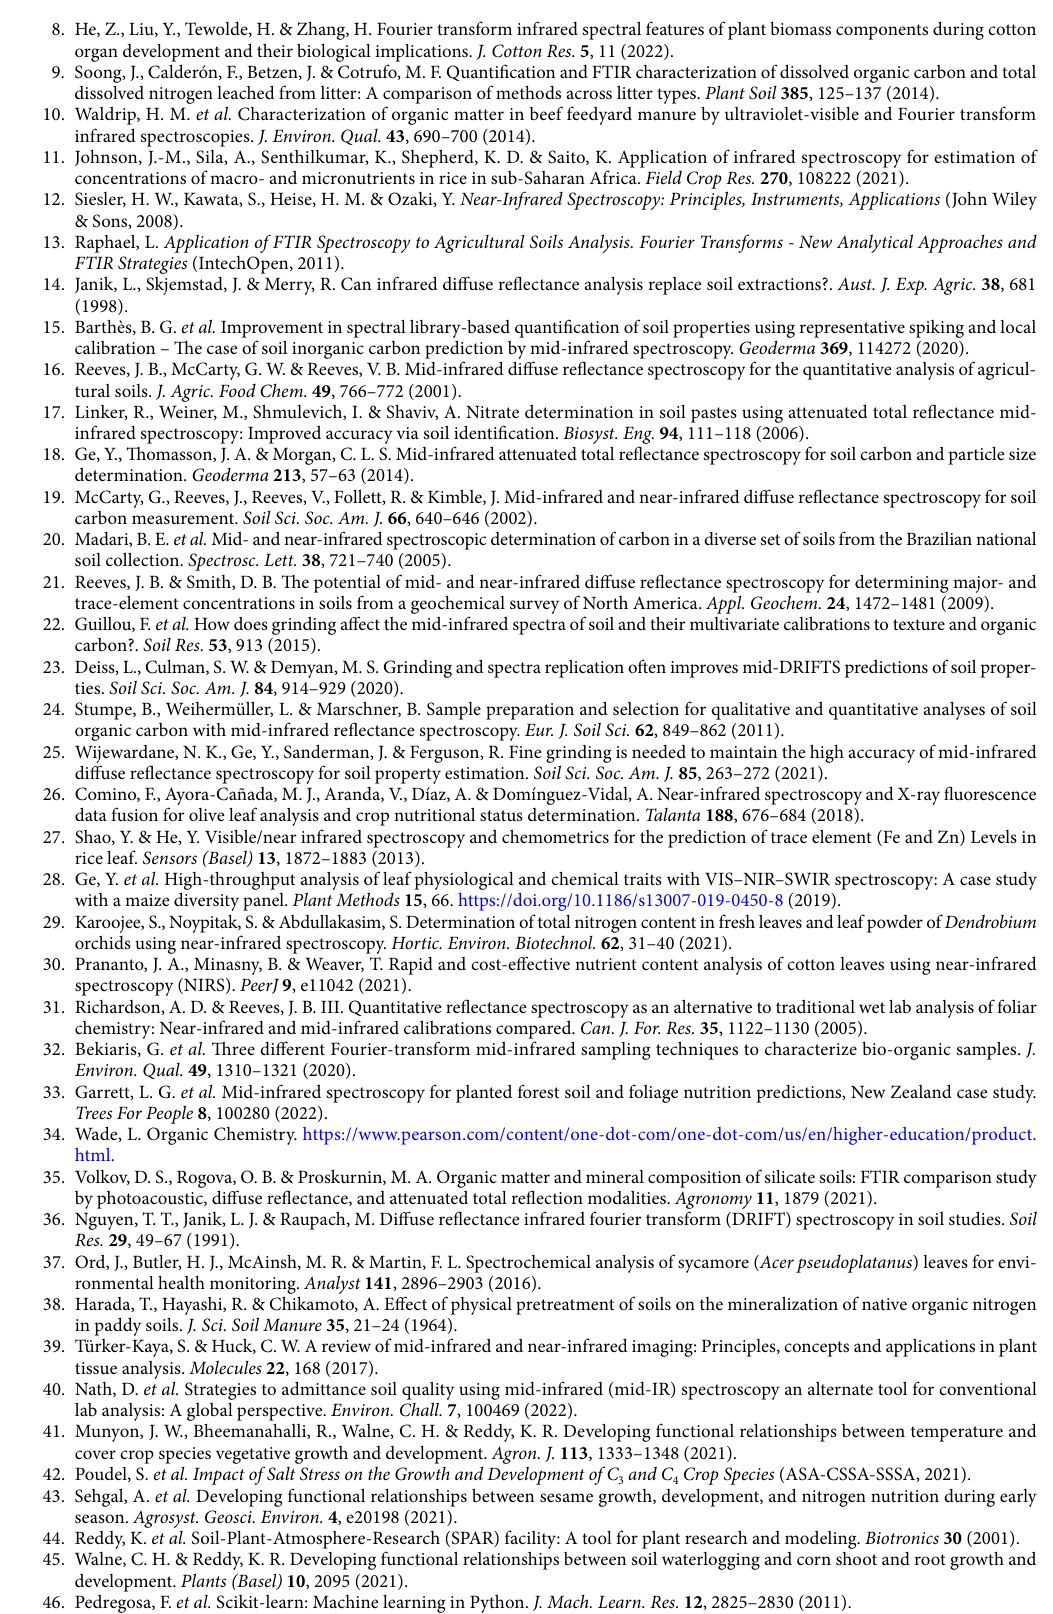
48. Plotly Technologies. Plotly: Low-code data app development. https:// plotly. com/. 49. The pandas development team, T. pandas development. pandas-dev/pandas: Pandas. (2022). https:// doi. org/ 10. 5281/ zenodo.